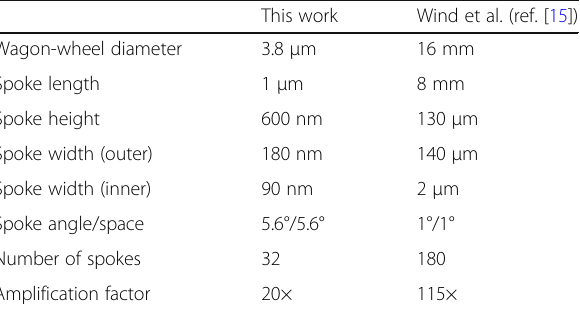
Table 1 Scaled-down wagon-wheel dimensions. Previously reported wagon-wheel dimensions are shown in the last column This work Wind et al. (ref. [15]) Wagon-wheel diameter 3.8 μ m 16 mm 1 μ m 8 mm 600